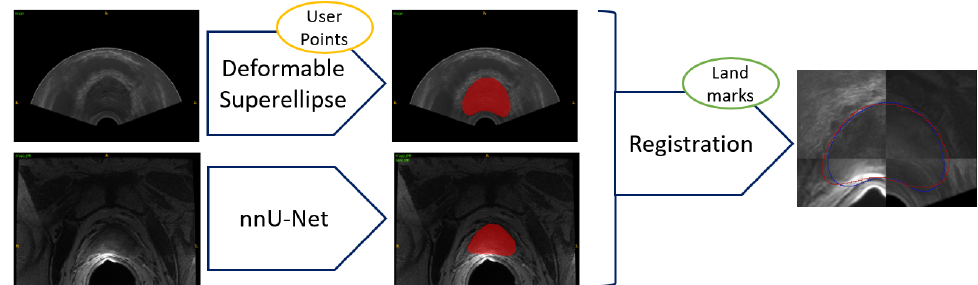
Figure 3. Workflow for TRUS and MRI segmentation and subsequent image fusion. Segmentation from TRUS is achieved in a semiautomatic way by fitting a 3D model based on deformable superel- lipses starting from user-defined points in at least three slices. Segmentation from MRI is performed fully automatically by exploiting the nnU-Net framework. Registration can be either performed in an automatic way, or the user can add anatomical landmarks to constrain the space of